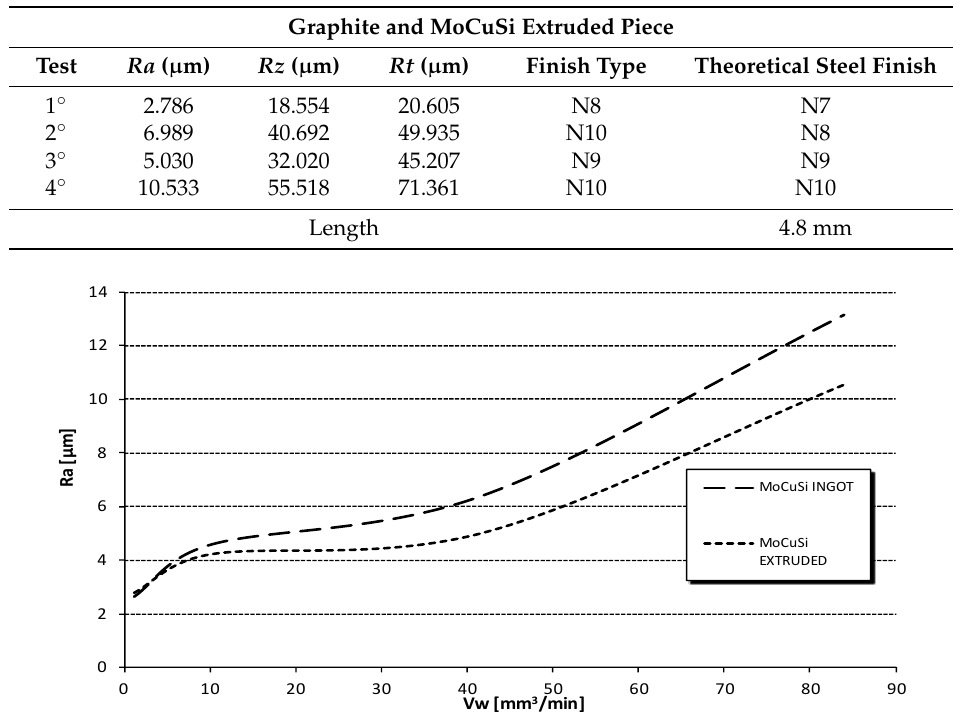
Table 12. Results for surface finish with the extruded MoCuSi.